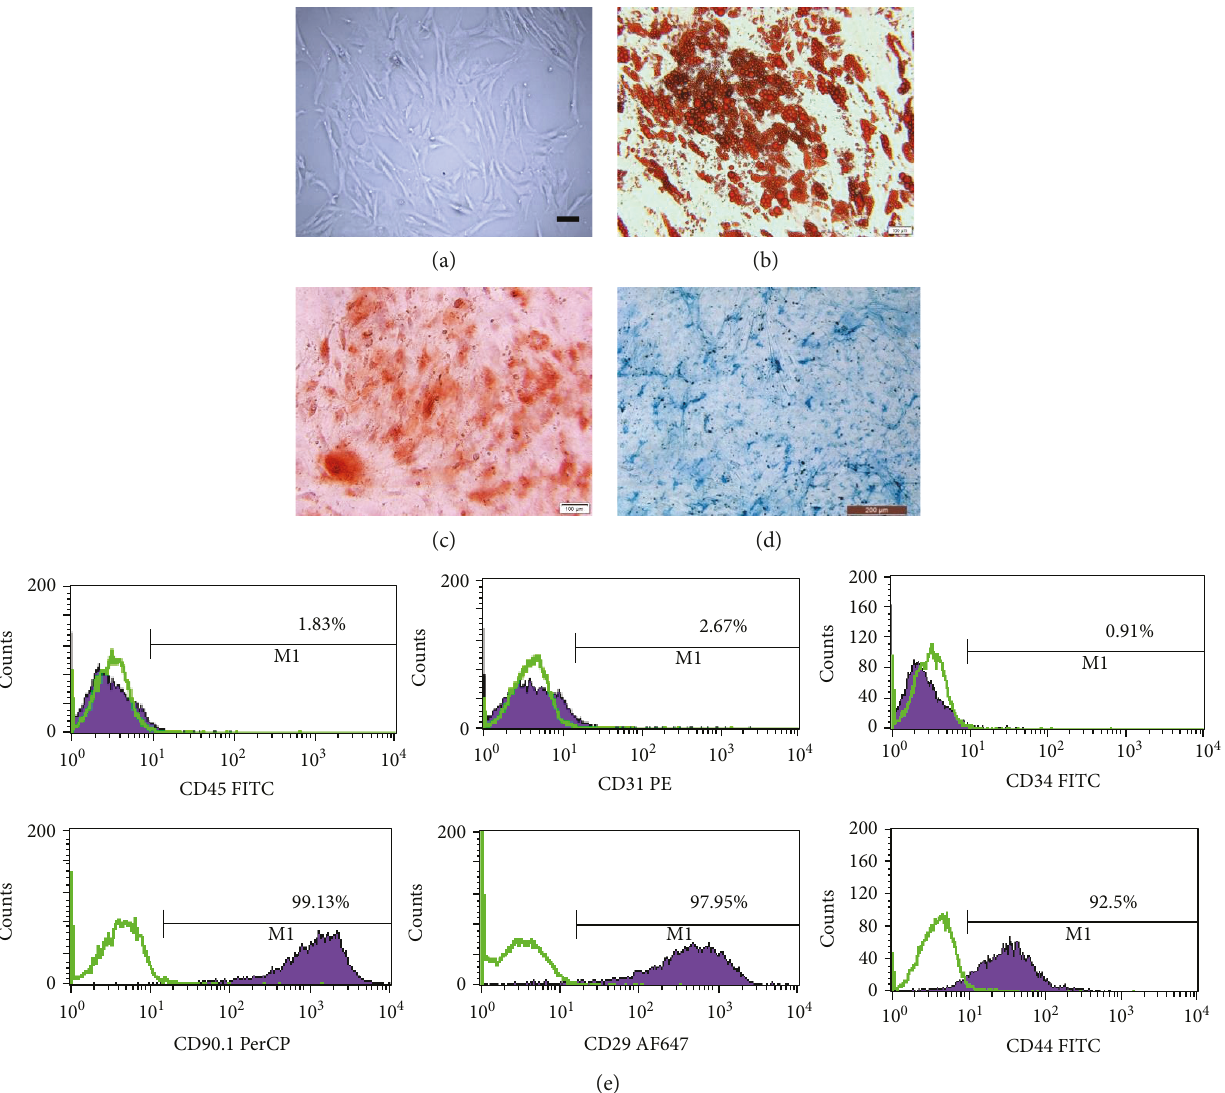
Figure 2: Characterization of rat adipose-derived mesenchymal stem cells (rASCs). (a) Passage 3 of cultured rASCs under light microscope. Representative pictures of (b) adipogenic, (c) osteogenic, and (d) chondrogenic induction for 3 w of rASCs followed by Oil red O, Alizarin red, and Alcian blue staining. Scale bar =100 μ m. (e) Flow cytometry analysis of the cell surface markers CD45, CD31, CD34, CD90.1, CD29, and CD44 expression at passage